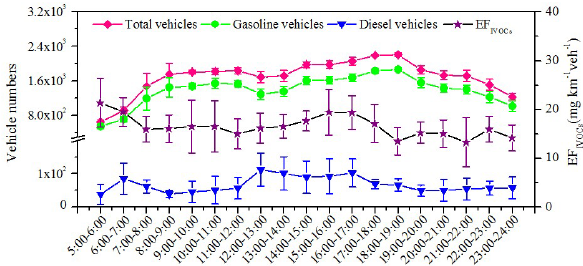
Figure 1. Diurnal variations of vehicle fleets and fleet-average EF IVOCs during the sampling period. Error bars represent 95% con- fidence intervals.